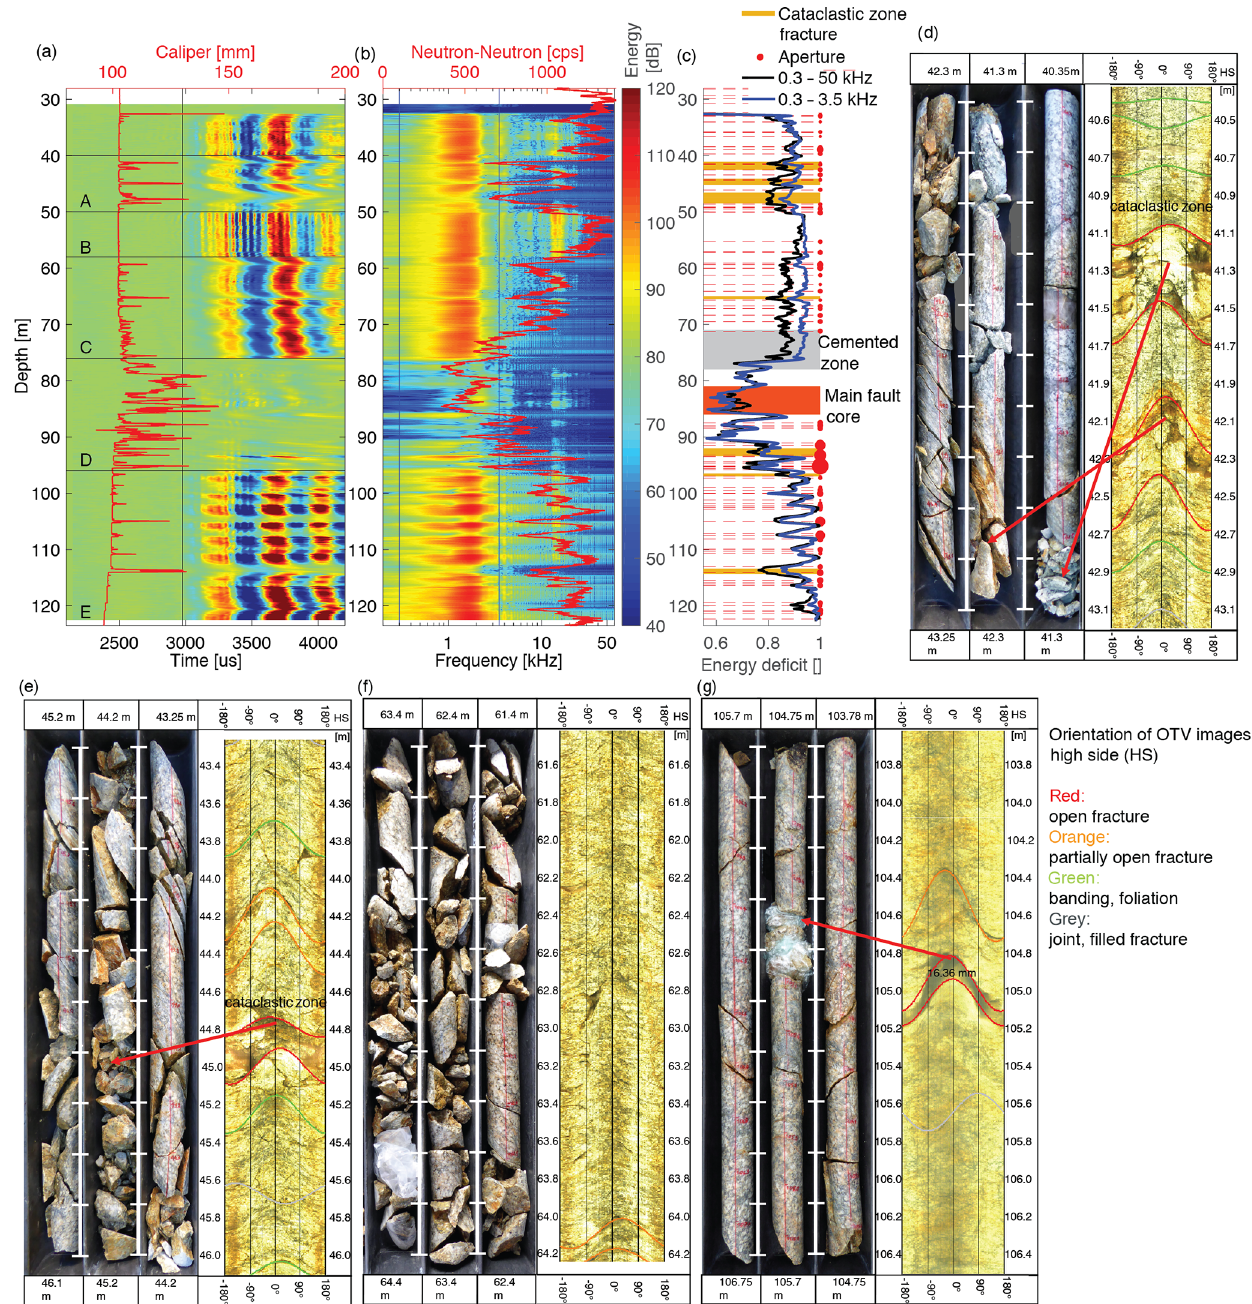
Figure 4. (a) Low-gain FWS data acquired with a nominal central frequency of 2kHz overlain by the caliper log; (b) corresponding power spectrum overlain by the neutron–neutron log; (c) relative energy deficit for two different frequency bands, one capturing the Stoneley wave and the other the complete spectrum, in conjunction with the first-cycle amplitude of the BHR direct wave and the brittle deformation data from the OTV; (d–g) examples of brittle deformation based on a comparison of OTV data and corresponding drill core